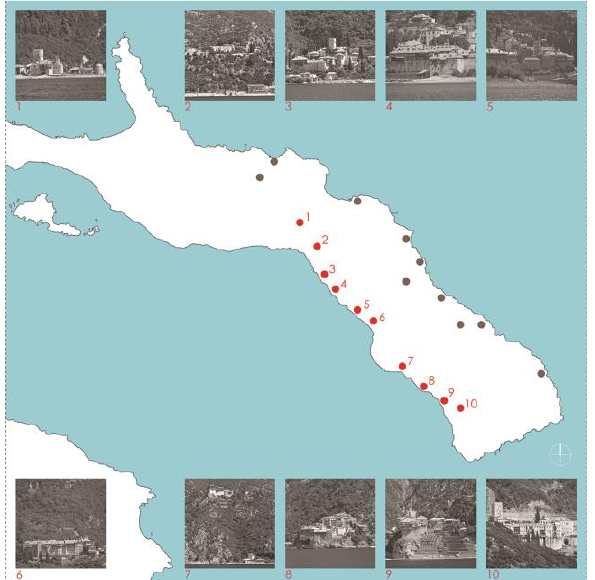
Figure 9 . The Monasteries of Mount Athos. Planimetric identification of the Monasteries in red.